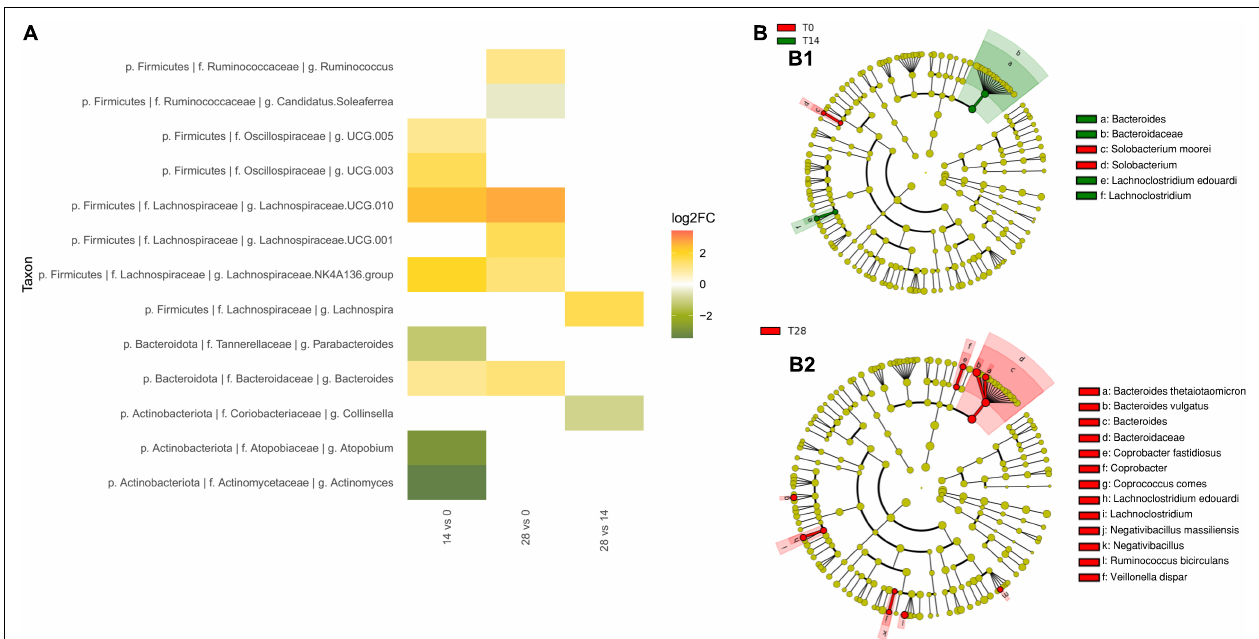
FIGURE 3 | Effect of tannin supplementation on fecal microbiota. (A) Fold-changes in the relative abundance at genus level. All changes significant (unadjusted p < 0.05) at nominal level by ANCOM tests between T0 vs. T14d, T0 vs. T28d, and T14d vs. T28d are shown. (B) Taxonomic biomarkers characterizing the differences between (B1) T0 and T14d, and (B2) T0 and T28d according to LEfSe and represented with a cladogram visualization ( p < 0.05, logarithmic LDA score ≥